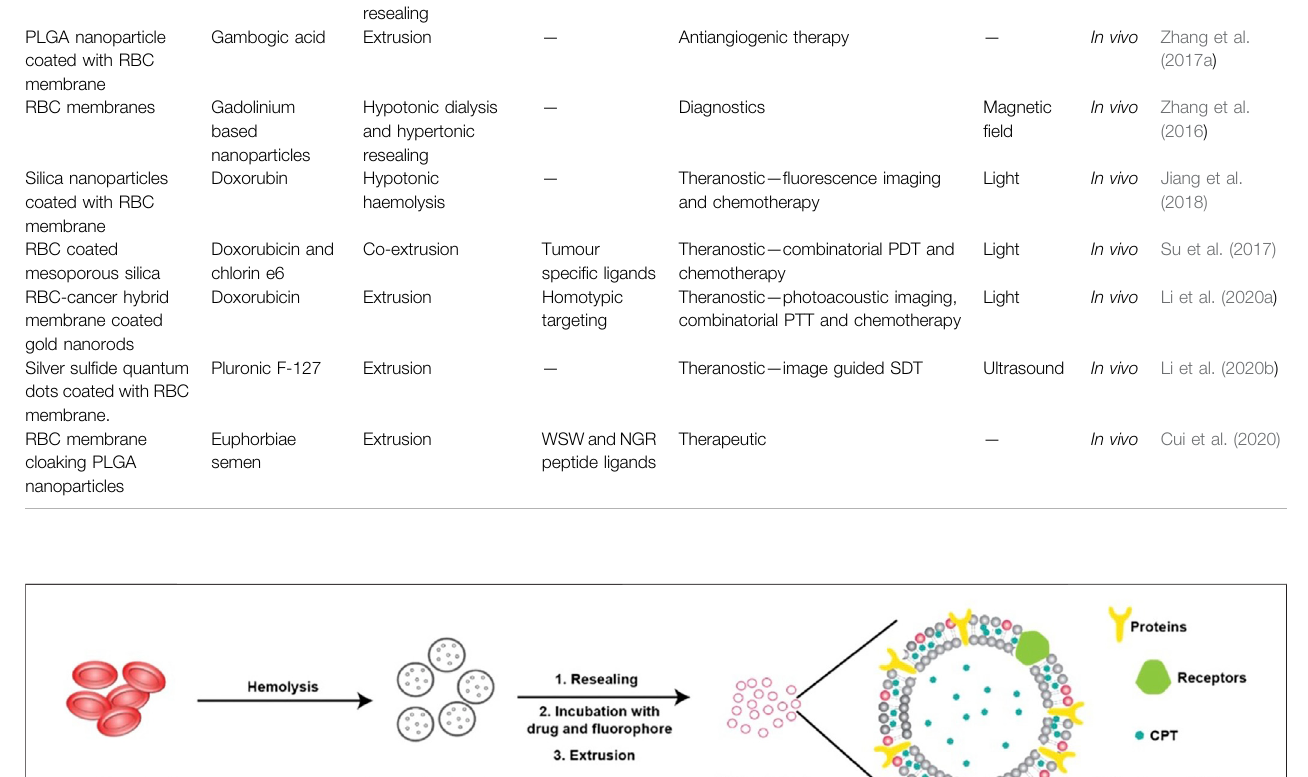
Frontiers in Chemistry |